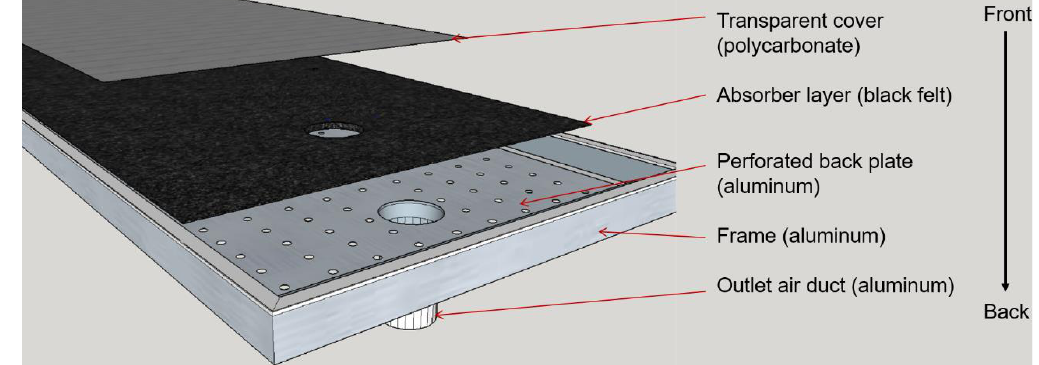
Figure 1. Exploded view of the studied solar air heater.